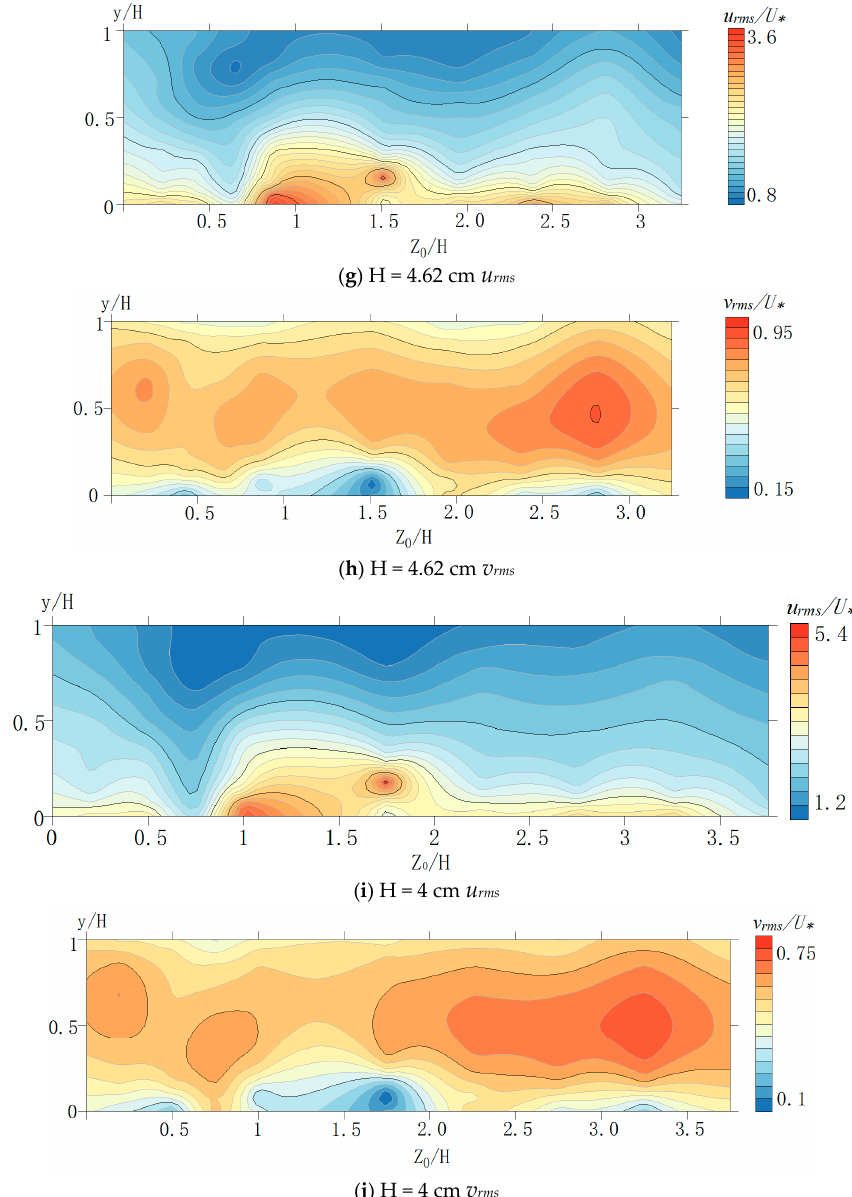
Figure 10. Non-dimensional turbulence intensity distribution in the cross section.